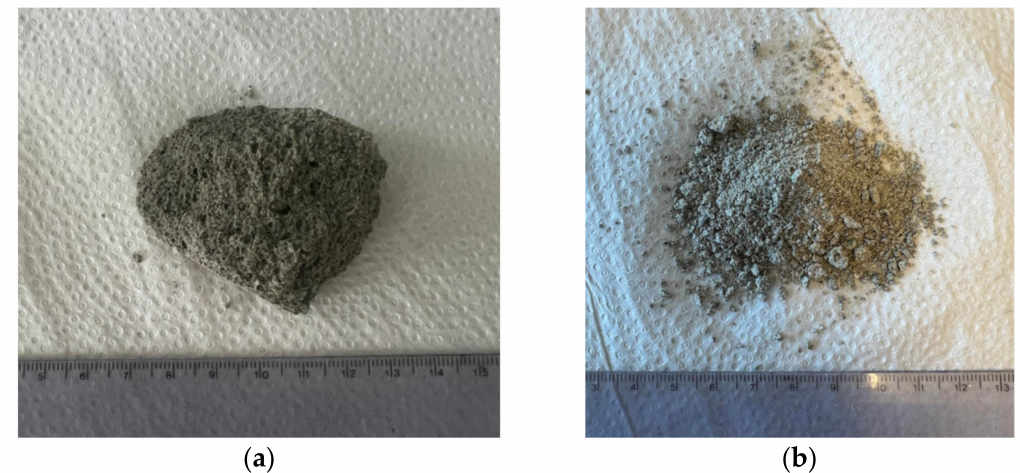
Figure 8. Geopolymer with alkali pre-treated MSWIBA subjected to leachability tests: ( a ) geopolymer monolith form; ( b ) geopolymer crushed form.